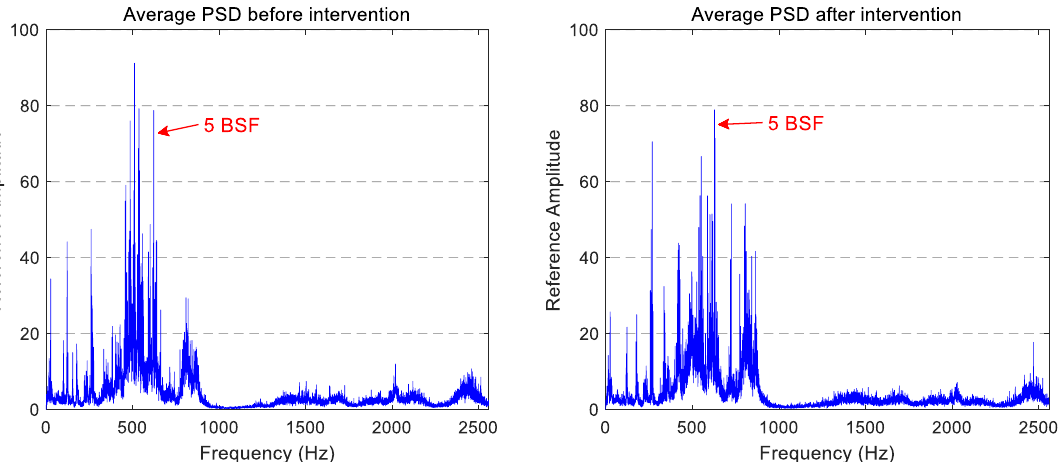
Figure 7. The comparison of the average spectrum for axial accelerations obtained before and after the wheels intervention.